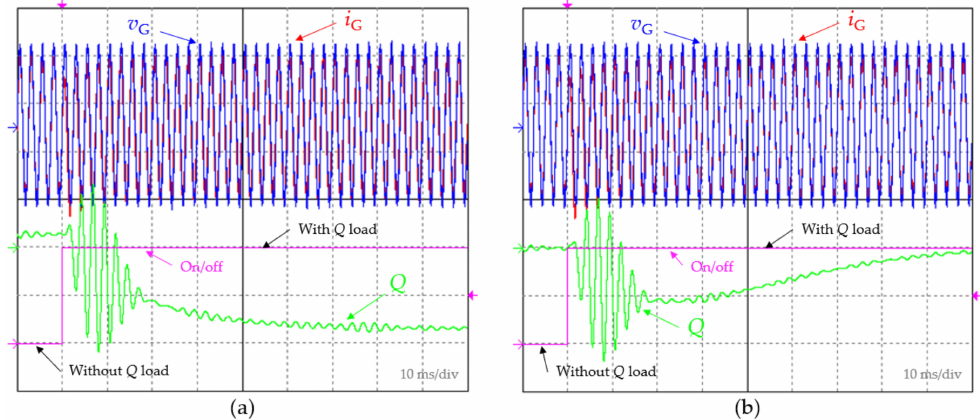
Figure 10. Dynamic response of the system to the connection of the load with the reactive power component: waveforms of the grid voltage v G and grid current i G , the reactive power Q ; the signal activating an additional load on/off registered for ( a ) classically controlled grid converter without reactive power compensation and for ( b ) proposed